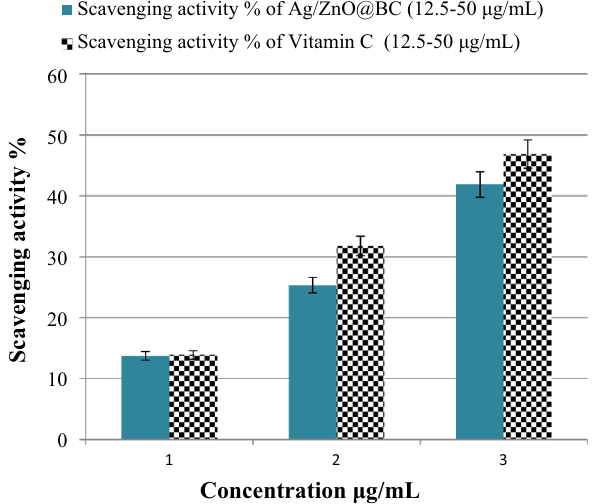
Figure 13. Antioxidant efficiency of Ag/ZnO@BC and Vitamin C (positive control) against DPPH.